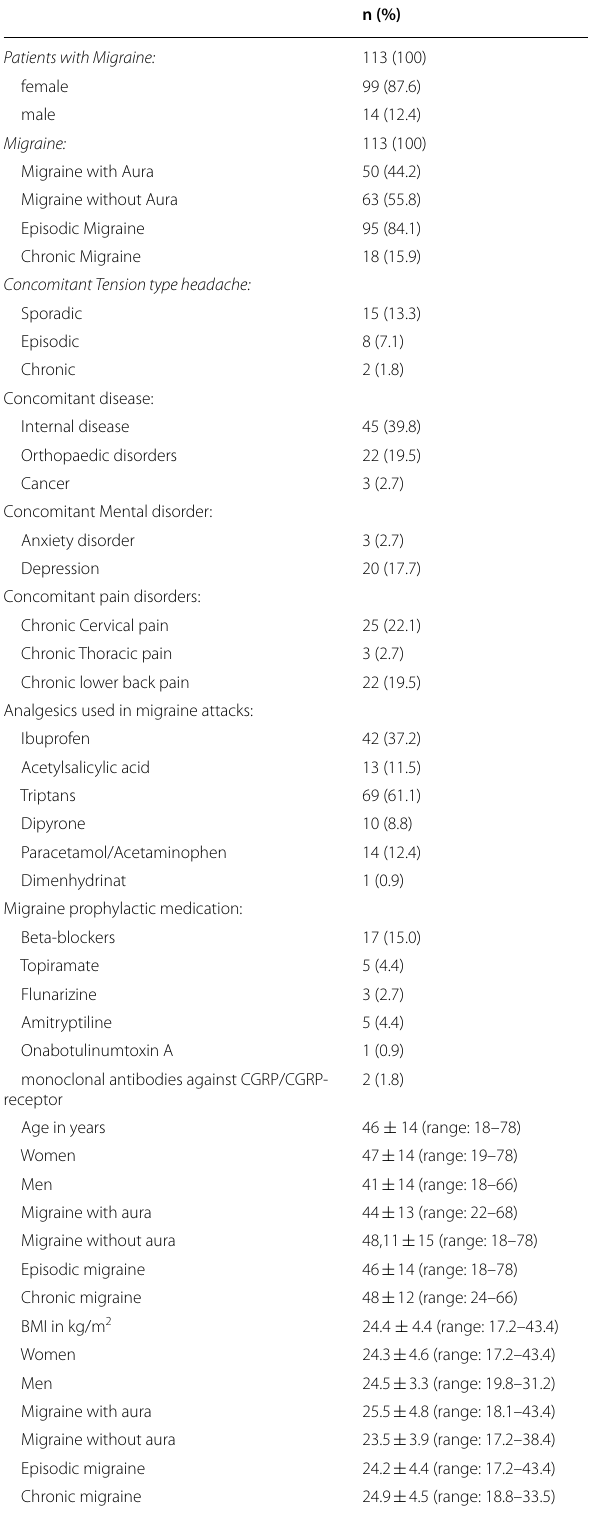
Table 1 Clinical characteristics of patients with